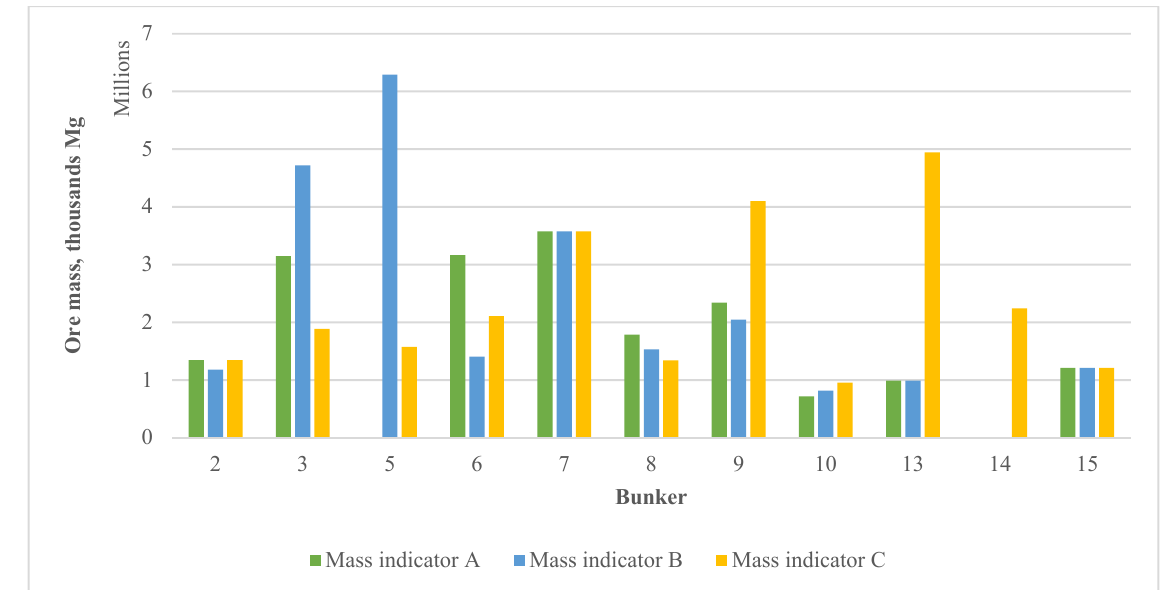
Figure 15. Mass indicator values for the elements A, B, C of the analyzed bunkers .